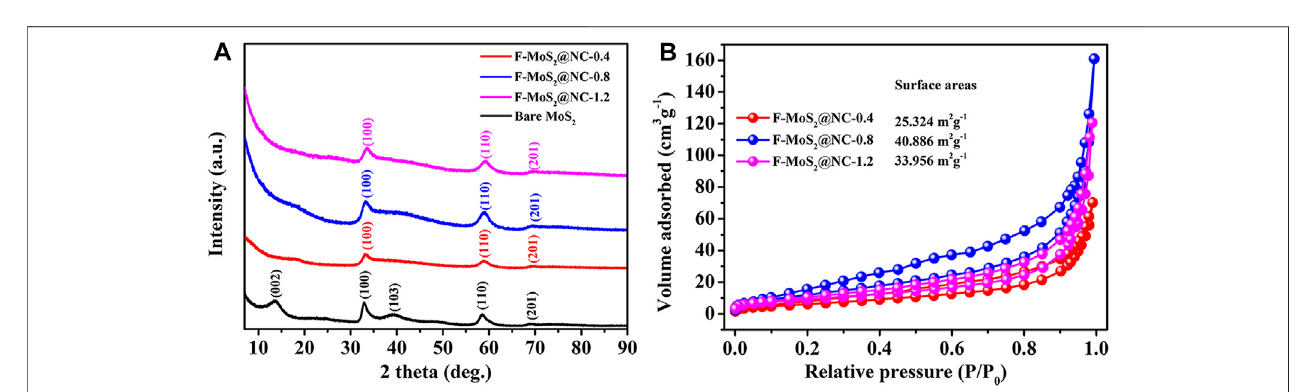
FIGURE 2 | (A) XRD patterns of bare MoS 2 , F-MoS 2 @NC-0.4, F-MoS 2 @NC-0.8 and F-MoS 2 @NC-1.2; (B) nitrogen adsorption-desorption curves of F-MoS 2 @ NC-0.4, F-MoS 2 @NC-0.8 and F-MoS 2